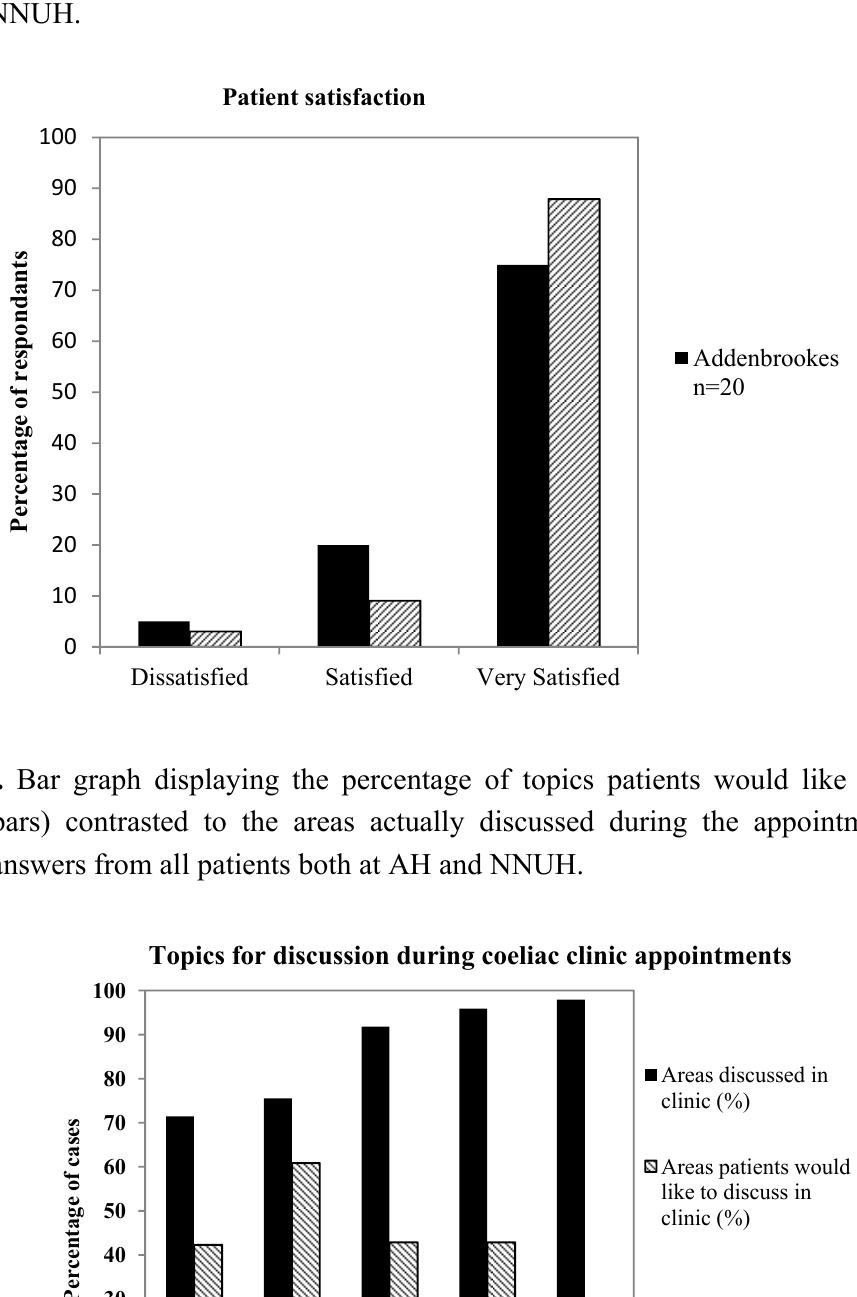
Figure 2. Comparison of parent satisfaction levels at AH (solid bars) and NNUH (hashed bars). Satisfaction levels are mostly very high in both sites, with slightly higher levels noted in NNUH.